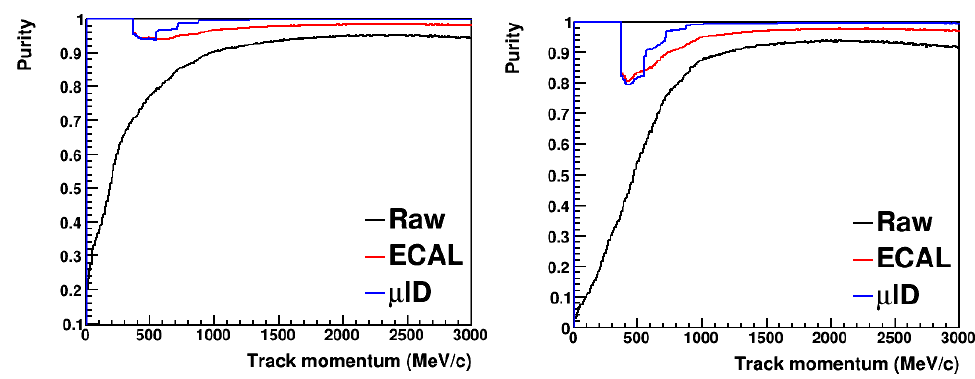
Figure 87. On the ( left ), the purity curve for the muon sample in FHC mode. On the ( right ), the purity curve for the muon sample in RHC mode. Both plots include muons and pions that range out in the